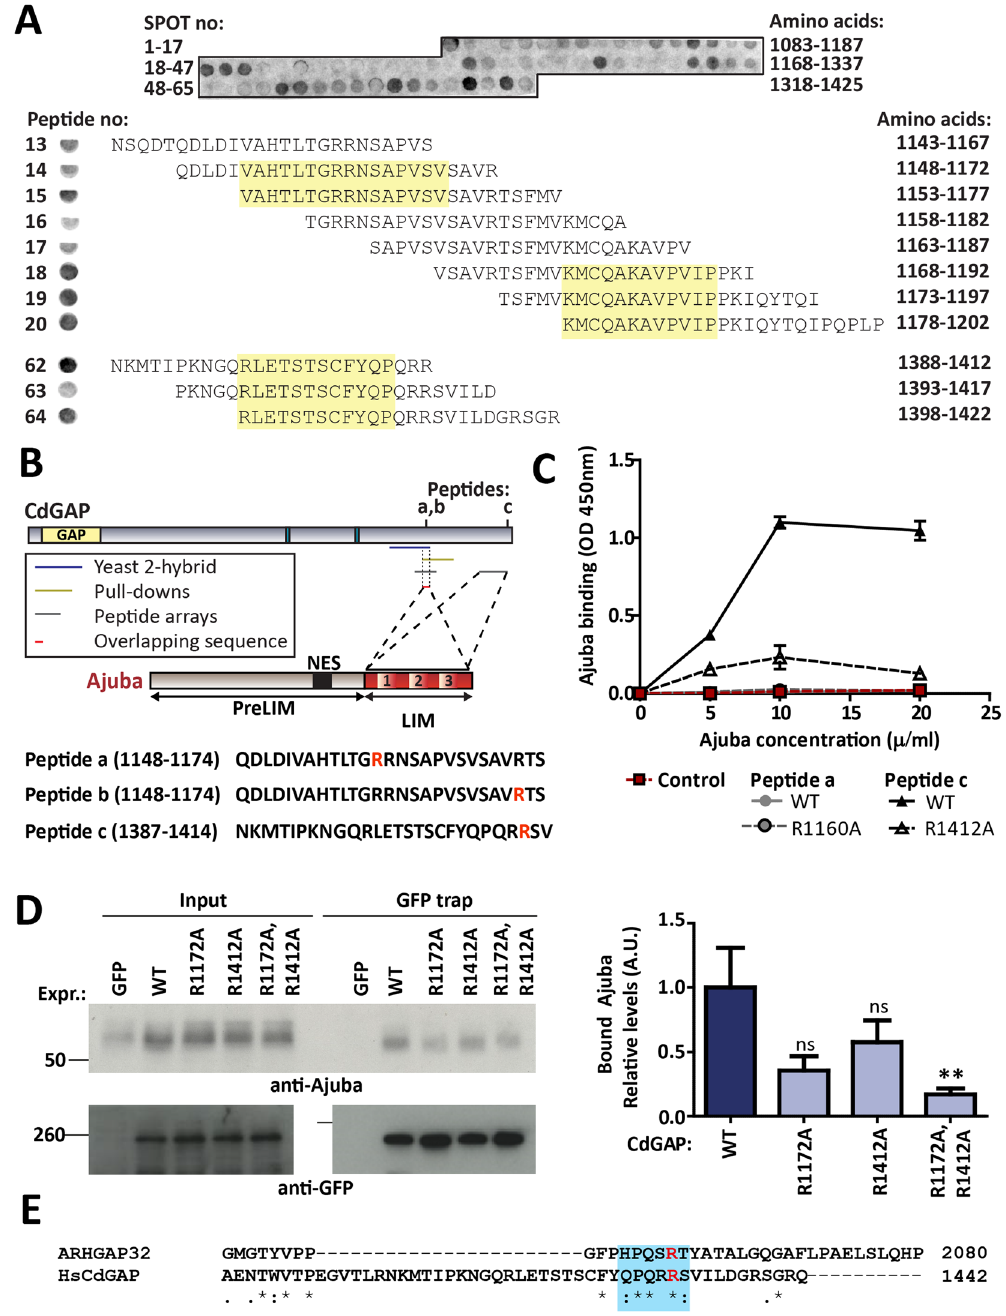
Figure 5. Conserved residues on CdGAP are responsible for the binding to Ajuba. ( A ) Peptides (25-mer) covering the C-terminus of CdGAP (amino acids 1083–1425) with 5 amino acid overlap were spot synthesised on a cellulose membrane and incubated with in vitro translated myc-Ajuba. Positive interactions were detected with an anti-myc antibody and visualised as a dark colour on the membrane. Peptide numbers along the CdGAP C-terminal sequence (Peptide no) and the amino acids contained in each peptide (Amino acids) are shown on the left and right hand side of the membrane, respectively (i.e. peptide number 1 contains amino acids 1083–1107). Sequences of highly reactive SPOTs are shown below the membrane and amino acid overlaps are shaded in yellow. ( B ) Overview diagrams of the interacting region between CdGAP and Ajuba to identify the minimal binding site on CdGAP: yeast two-hybrid (amino acids 1064 to 1183; navy blue line); pull-down assays (amino acids 1160 to 1253; yellow line) and peptide arrays (shorter peptides within the C-terminal region; grey lines). Selective reactive sequences from the peptide array ( A ) are listed below CdGAP diagram (peptides a–c). ( C ) Increasing concentrations of His-Ajuba were incubated with immobilized peptides on ELISA plates covering the wild-type CdGAP regions or with mutations at residues R1160A (peptide a) or R1412A (peptide c). ( D ) Keratinocytes were transfected with wild-type GFP-CdGAP or different mutants to test impaired binding to endogenous Ajuba. Cells were lysed and GFP-tagged CdGAP proteins precipitated (GFP-trap)